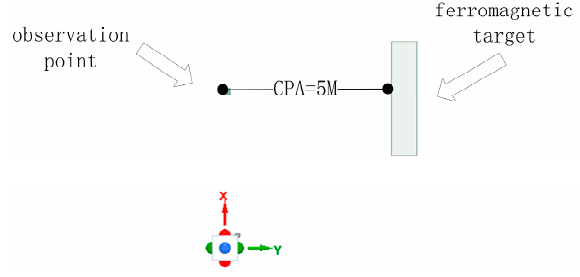
Figure 1. Moving target detection model.